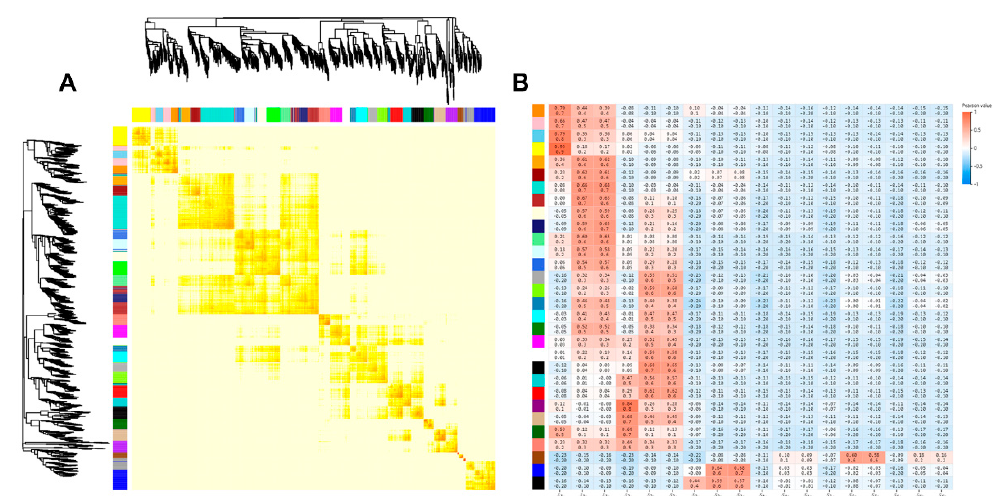
Figure 3. Co-expression network during rhizome development. ( A ) Weighted gene co-expression network analysis (WGCNA) analysis of RNA sequencing (RNA-seq) data from different stages of rhizome development. ( B ) Network hubs regulating genes in the differentiation stage. Colors indicate the genes displaying peak expression in corresponding stages.